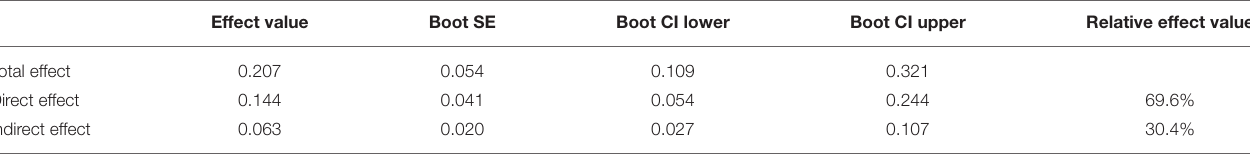
TABLE 4 | Analysis of total effect, direct effect and indirect effect.